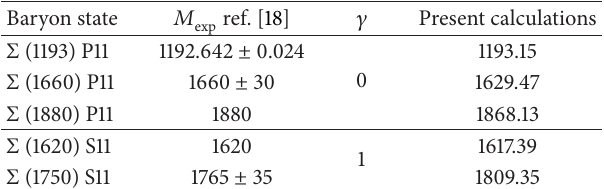
Table 5: The present calculations of Σ baryon states in comparison to the experimental data [18] in